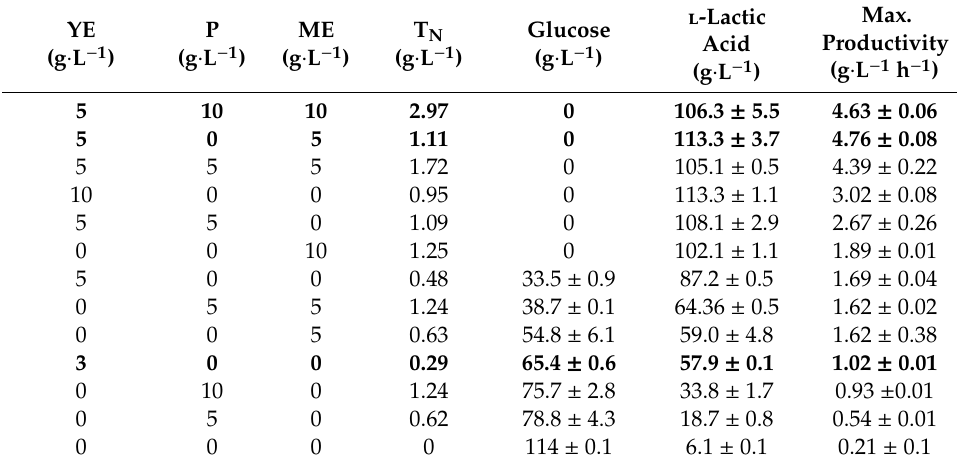
Table 1. Reduction of the complex components yeast extract (YE), peptone (P), and meat extract (ME) in MRS medium and e ff ect on final titer after 70.5 h and maximum productivity of l -lactic acid: 37 ◦ C, 400 rpm, and 24-well plates. T N was calculated based on results of Klotz et al.